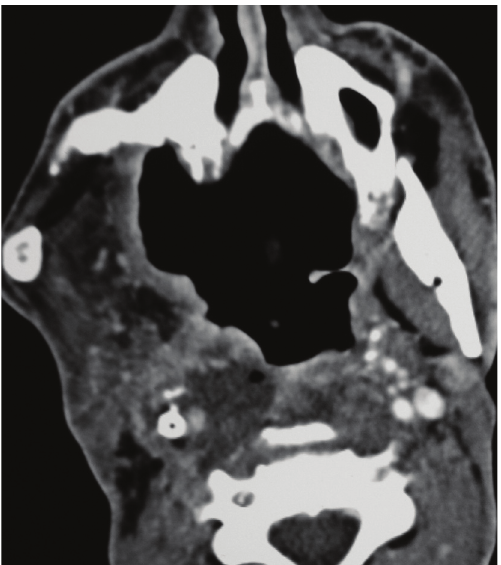
Figure 1: Contrast Enhanced computed tomography scan of the neck showing the right carotid stent occluded with no blood flow in the lumen. The carotid is surrounded by the ulcerative mass.